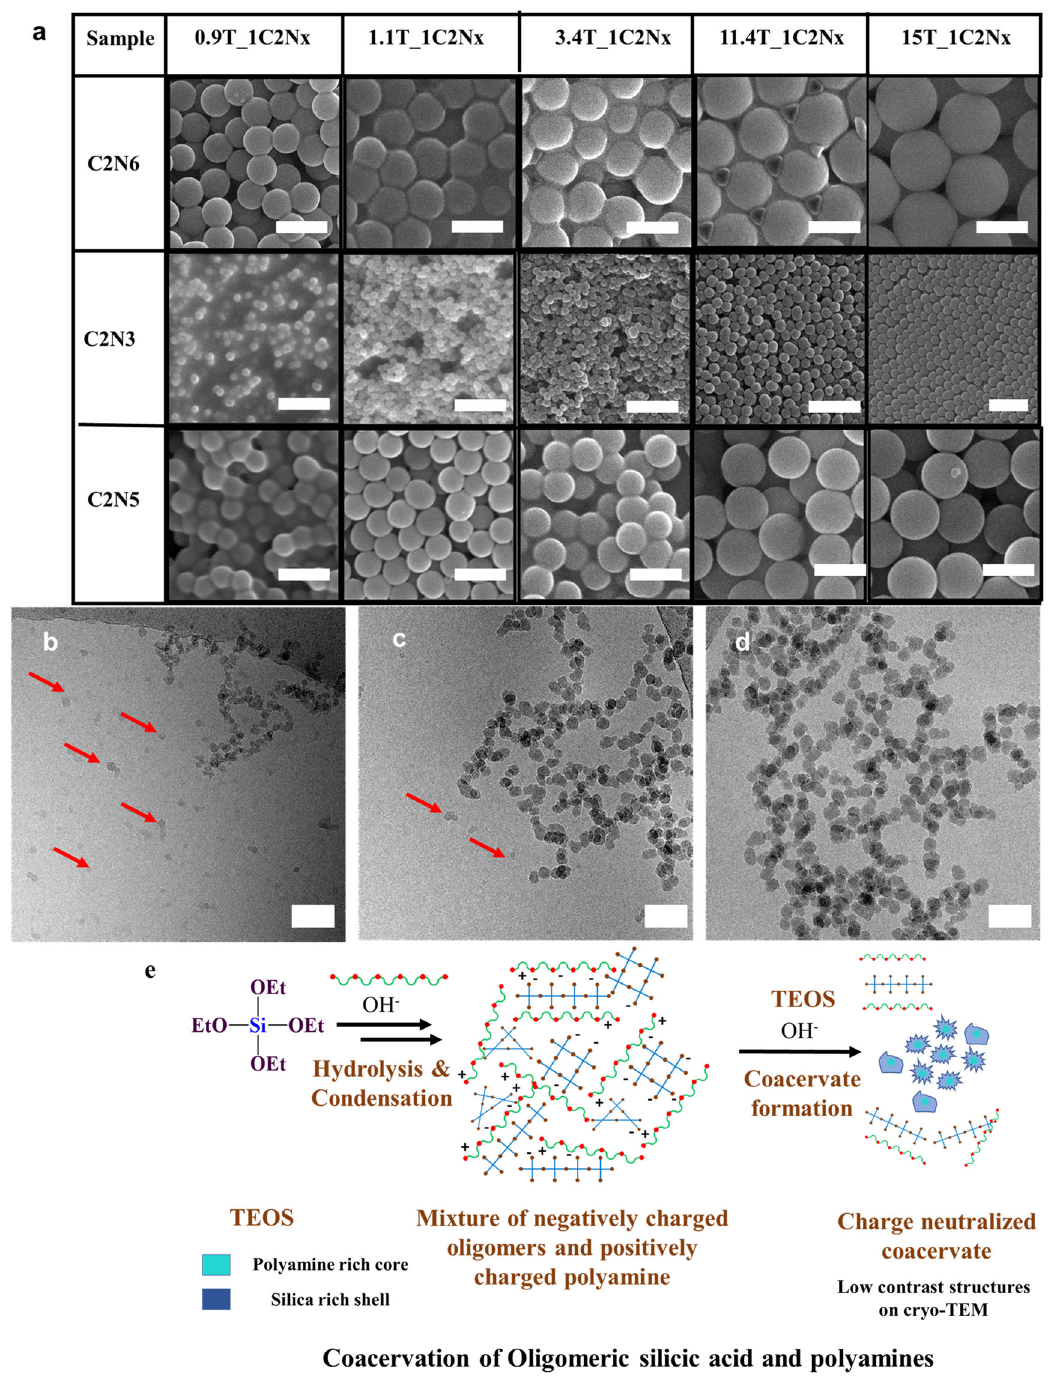
Fig. 3 Electron Microscope images of bioinspired silica synthesis using polyamines of different chain lengths and at varying z TEOS_1C 2 N x mole ratios. a SEM images of Silica particles grown in presence of 22 mM polyamines at various amounts of TEOS (scale bar 500 nm); Silica particles produced in presence of 22 mM C 2 N 3 at 0.70TEOS_1C 2 N 3 mole ratio samples vitri fi ed at: b 60 min, c 75 min, d 90 min (scale bar 50 nm). Low contrast structures are highlighted with red arrows. e Schematic representation of coacervate formation between oligomeric silicic acid and polyamines by charge matching. presence of longer polyamines a higher weight percentage of Solid state magic angle spinning (MAS) NMR measurements organic molecule was incorporated compared to those produced were carried out on freeze-dried particles to reduce inter and in presence of shorter polyamines, as is expected based on the intraparticle silanol condensations during sample preparation. 1 H NMR analysis on 617 ± 20 nm particles (15T_1C2N6) produced molar mass of the polyamines. Based on the TGA data, the in presence of C 2 N 6 gave a broad spectrum (Supplementary Si:polyamine ratios of around 1:0.06 were obtained in all cases, Fig. S10a). The peak centred at 6.6 ppm was assigned to con fi rming that around 90 percent of the molar amount of protonated primary amine 43 (R-NH 3 + ) and the peaks centred polyamines added to the reaction mixture were incorporated into at 3.6 and 1.2 ppm were assigned to physisorbed water and the particles. COMMUNICATIONS CHEMISTRY| (2021) 4:160